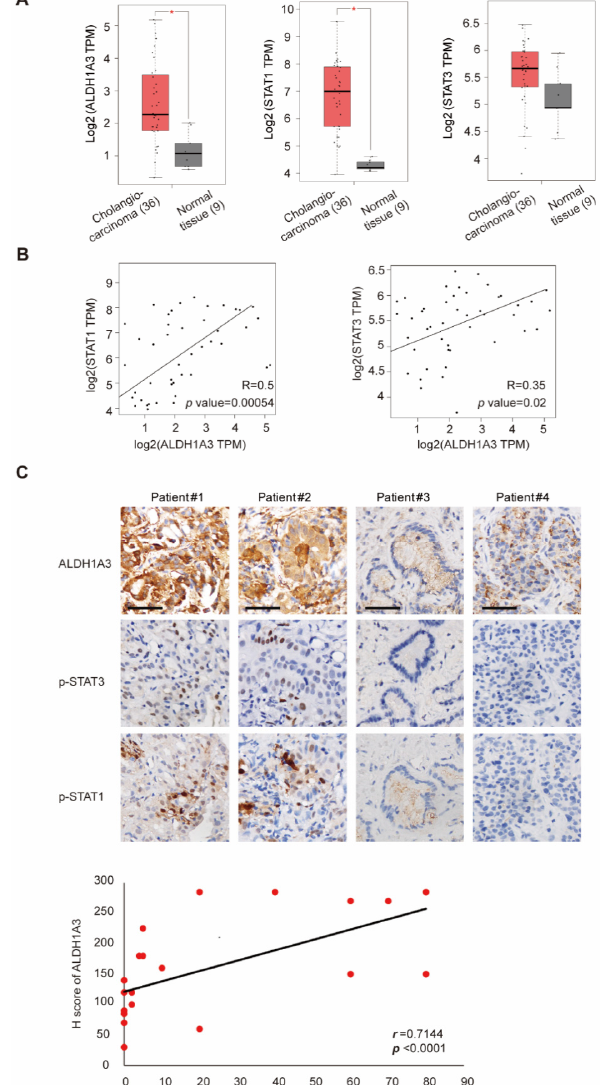
Figure 5. Expression of STAT1, STAT3, and ALDH1A3 in patients with cholangiocarcinoma. ( A ) Relative mRNA expressions of ALDH1A3, STAT1, and STAT3 from TCGA databank in cholangio- carcinoma ( n = 36) and control samples ( n = 9). * p < 0.05 by Mann–Whitney U test. ( B ) Spearman’s rank correlation between the mRNA levels of ALDH1A3, STAT, and STAT3. The correlation co- efficients r and P values were obtained using GEPIA and are shown in each panel. ( C ) Upper: Representative imaged of immunohistochemical nuclear staining of ALDH1A3, pSTAT1 (Y701- phosphorylated STAT1), and pSTAT3 (Y705-phosphorylated STAT3) in human cholangiocarcinoma specimens. Scale bar = 50 µ m. Lower: Spearman’s rank correlation coefficient r and P values are shown in the panel ( n =